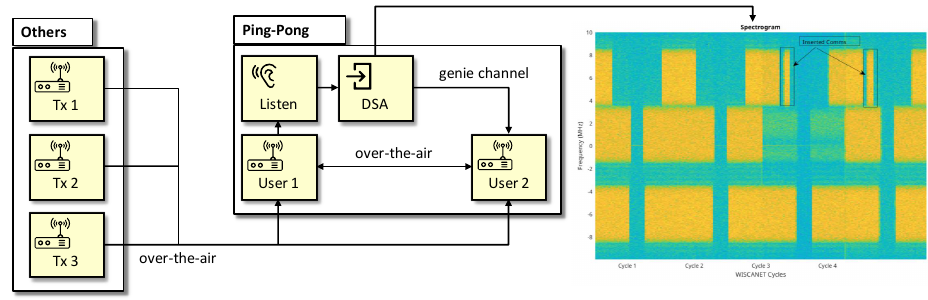
Figure 14. Block diagram of the dynamic spectral access configuration. Three users labeled “others” operate in different spectral allocations with arbitrary timing. The two users engaged in the ping- pong application constantly measure the spectrum, identify opportunities, and use these openings to communicate. The goal of this demonstration is to highlight how WISCANet and the pre-built ping-pong application enable rapid implementation and validation of novel PHY and MAC layer techniques